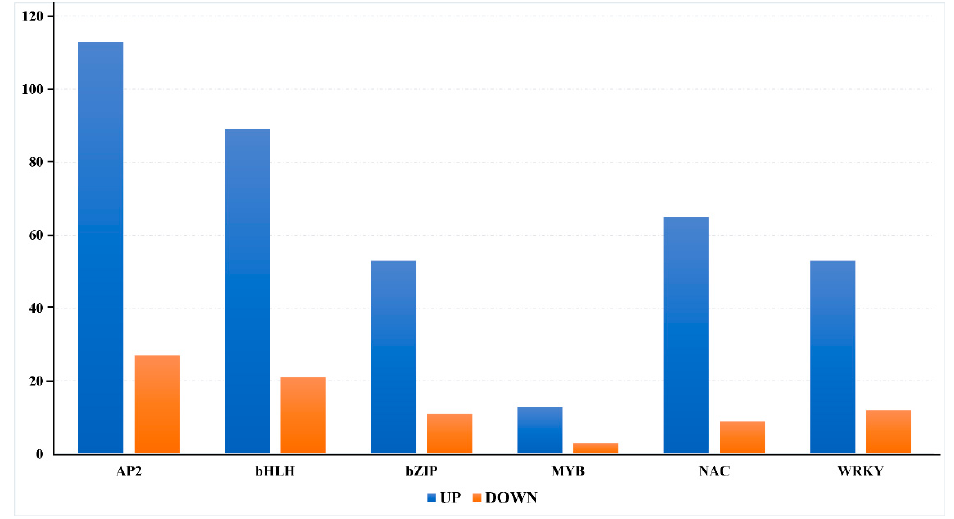
Figure 4. Summary statistics of the TF genes differentially modulated during CBCVd infection in the hop. TF genes with a fold change ( ≥ +2 and ≤− 2; p -value < 0.05) were considered to be significantly differentially modulated.